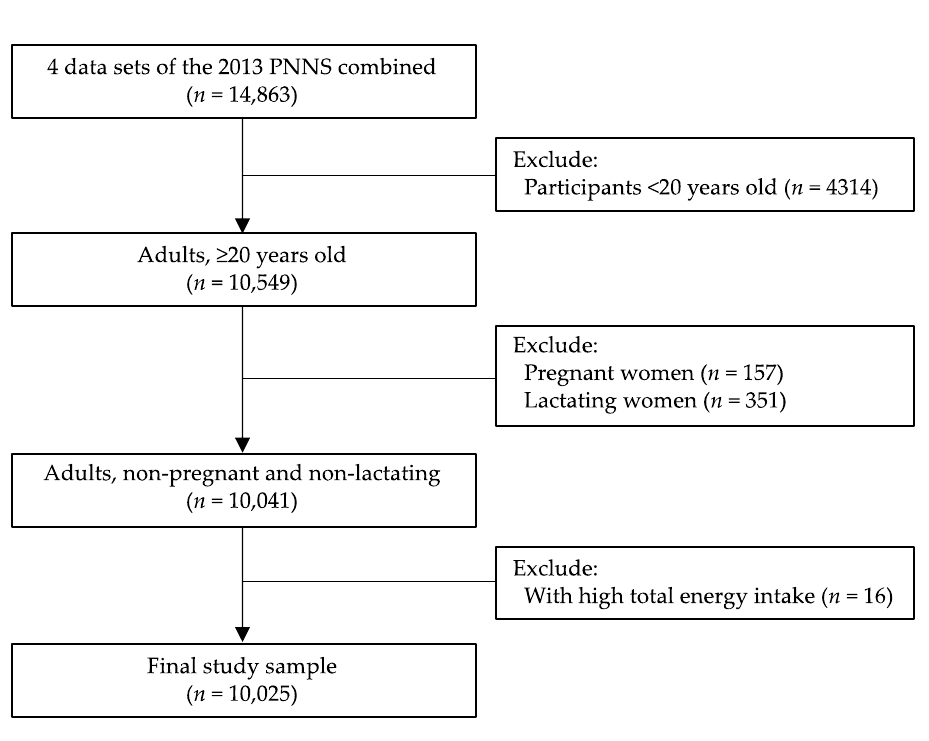
Figure 1. Study participant selection.